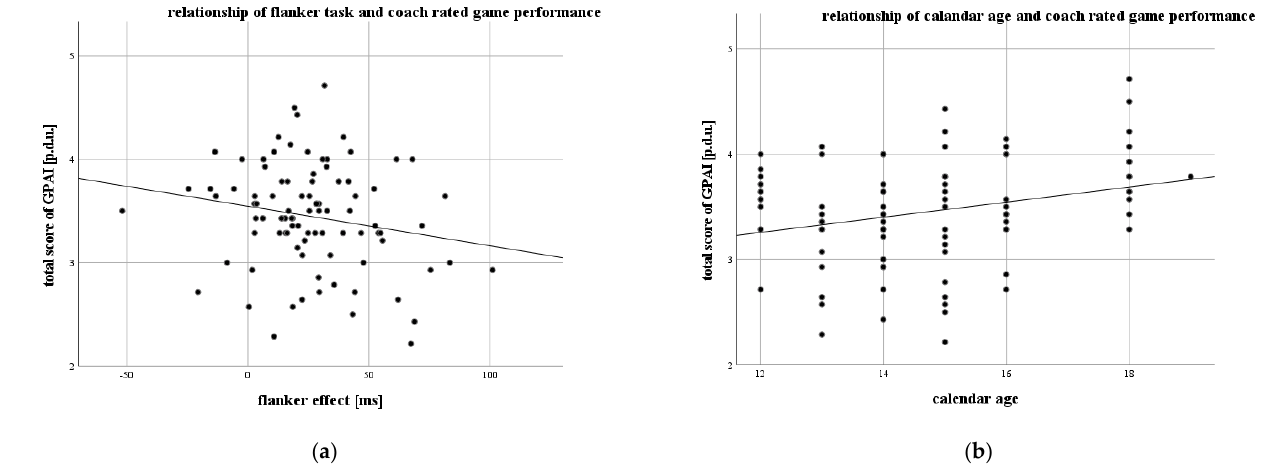
Figure 2. Partial relationship between flanker task performance ( a ) and calendar age ( b ) with coach rated game performance (GPAI).